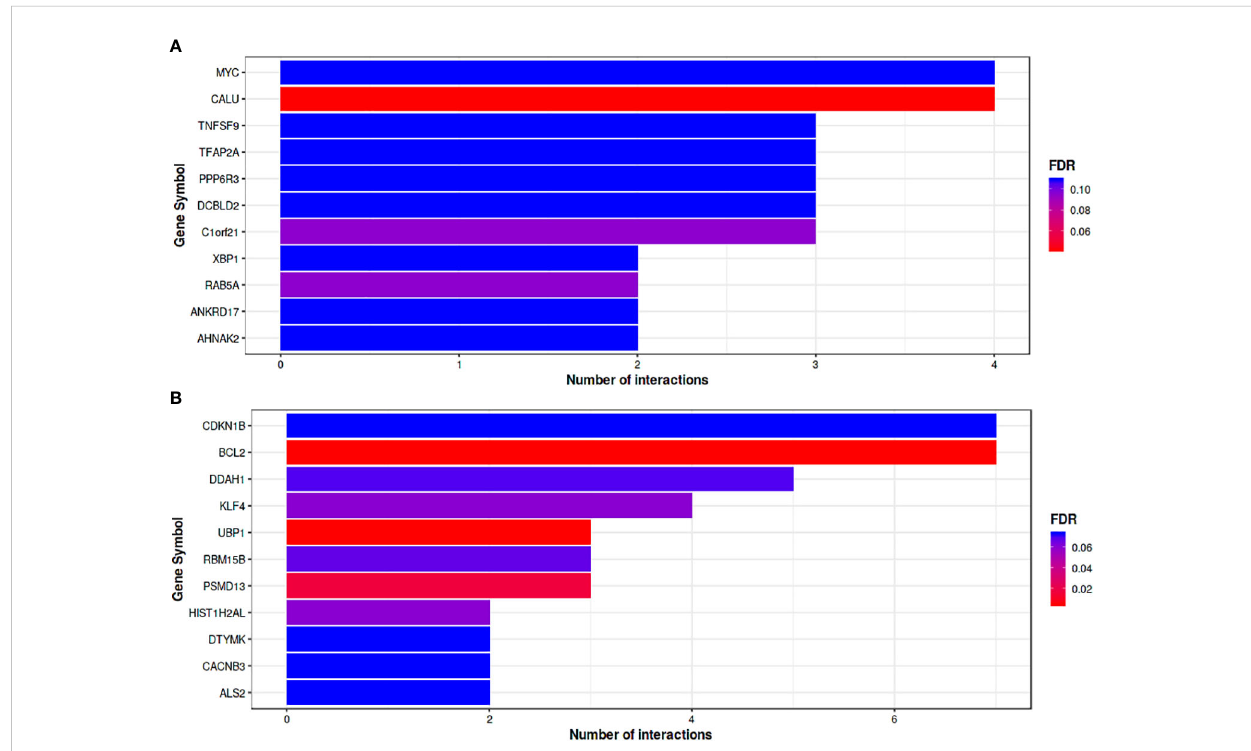
FIGURE 5 (A) Bar plot where the Y-axis refers to the top 11 target genes resulted from the enrichment. Analysis of down-regulated DEMs, while the X-axis represents the number of miRNAs targeting them. The color code re fl ects the FDR value increasing from red to blue. (B) Bar plot Represents top target genes for up-regulated DEMs. Gene symbol was represented by horizontal Axis and vertical Axis was used for number of interactions. Colors re fl ect FDR value form Red to